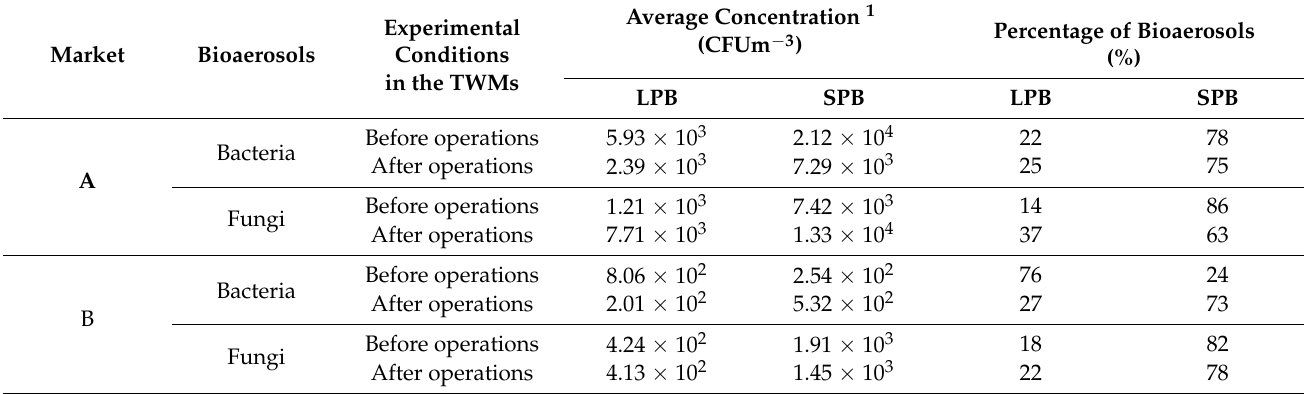
Figure 6. The BBs (CFU m − 3 ) present as ( a ) LPBs and ( b ) SPBs in Market B before operations commenced and ( c ) LPBs and ( d ) SPBs present after operations had finished. Red circular dots with English titles show the sampling locations.